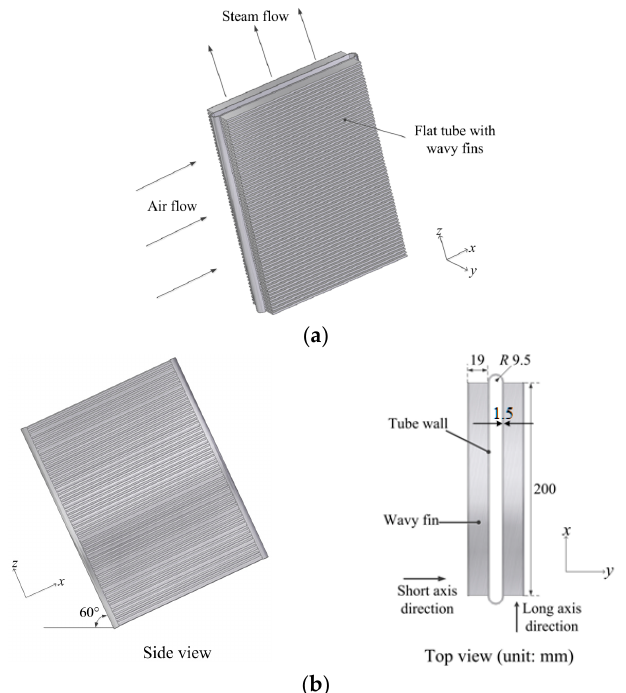
Figure 1. The physical models of the finned tube bundle of an ACC. ( a ) 3D view; ( b ) Side view and top view.